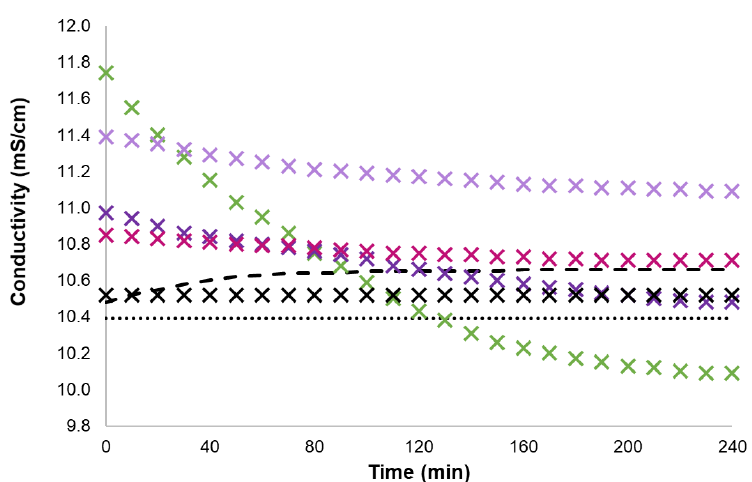
Figure 7. Conductivity data of 0.04 mol% IMC1, CH, ET3N, PY and of 0.08 mol% KCl in [C 2 mim][NTf 2 ] solution upon UV irradiation time at 25 ◦ C (round dot—[C2mim][NTf2], dash—BTF6, X black cross—KCl, X green cross—IMC1, X pink cross—CH, X lavender cross—ET3N, X purple